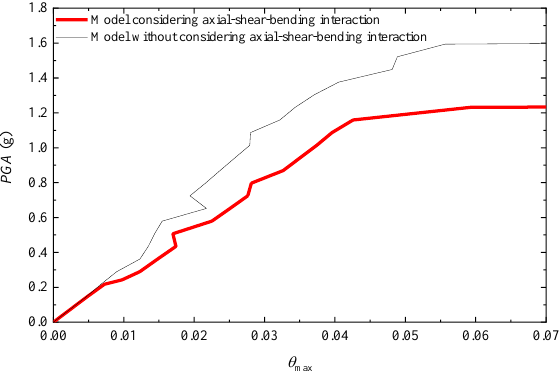
Figure 12. Comparison of IDA curves.